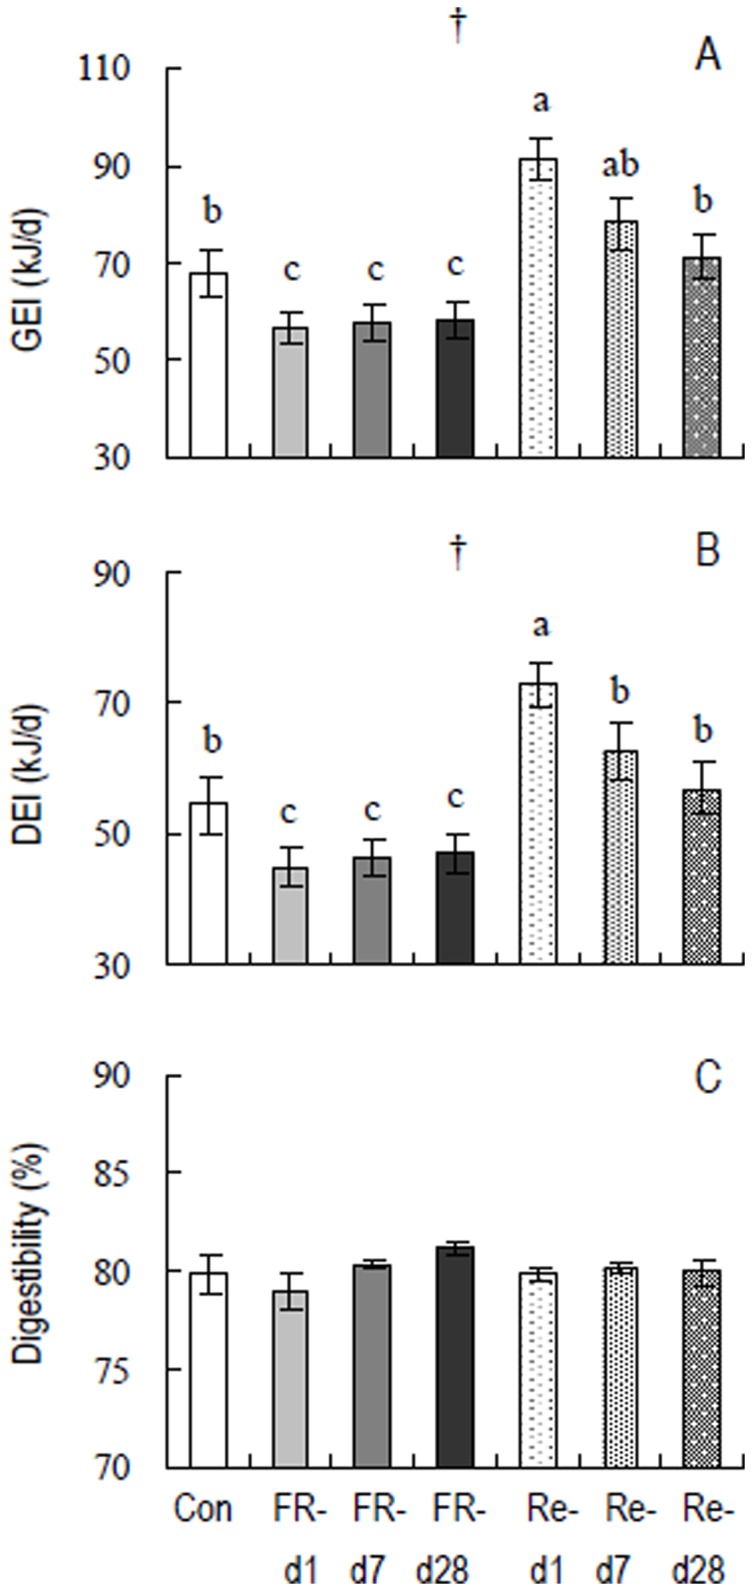
(A) Gross energy intake (GEI), (B) digestive energy intake (DEI), and (C) digestibility in striped hamsters subjected to food restriction and refeeding.Groups are the same as in Fig. 2. Effect of food restriction and refeeding is significant: †, P<0.01. Different letters above the columns indicate significant differences between the seven groups (P<0.05).